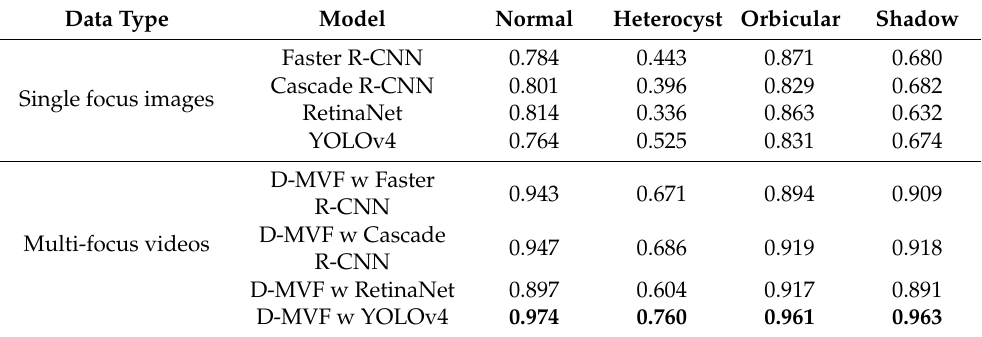
Table 2. Comparison of AP between various U-RBC detection methods using single-focus and multi-focus images in different typical morphologies of urinary red blood cells. The bolded numbers are the best results.